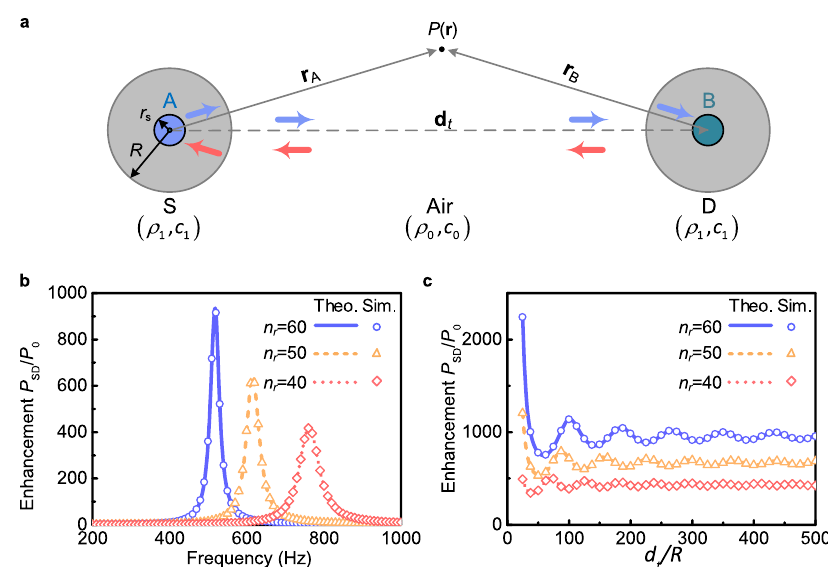
Fig. 2 Theoretical model of the RWM system. a Schematic of the system setup. A is a single point-like sound source of radius r s emitting a sine harmonic wave. B is a condensed microphone, which picks up the sensing signal. S and D are the high-refractive-index ( n r = c 0 / c 1 > 1) elements enclosing the source and detector, respectively. b Theoretical and simulated transfer enhancement from A to B using the RWM. Here the transfer distance d t is 325 times the element radius R . c Enhancement at different distances d t